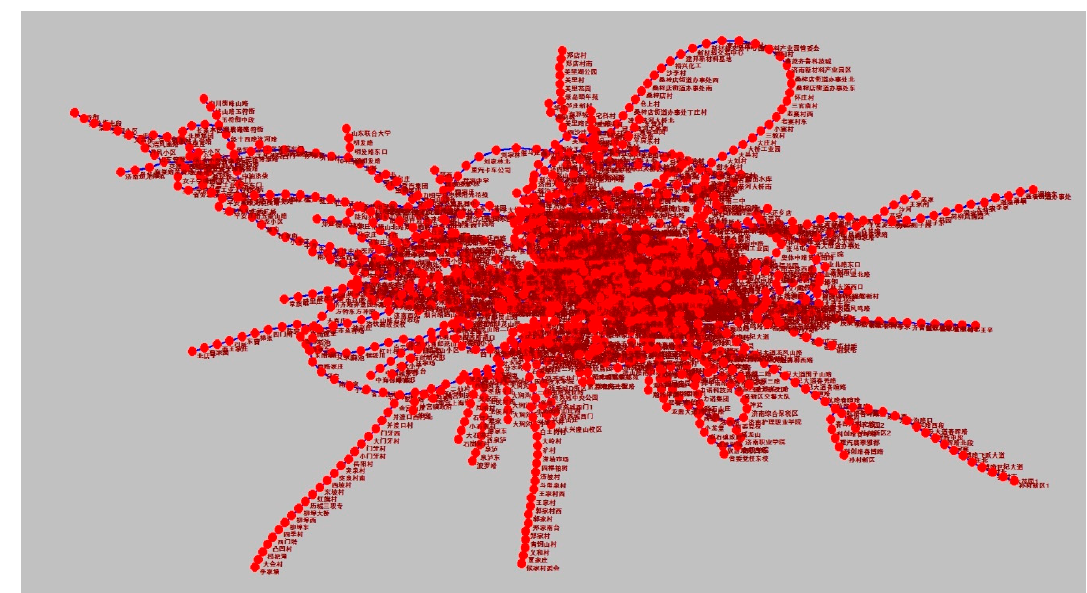
Figure 2. Public transportation network system floor plan. ( The Chinese in the figure is the actual place name of Jinan City.).